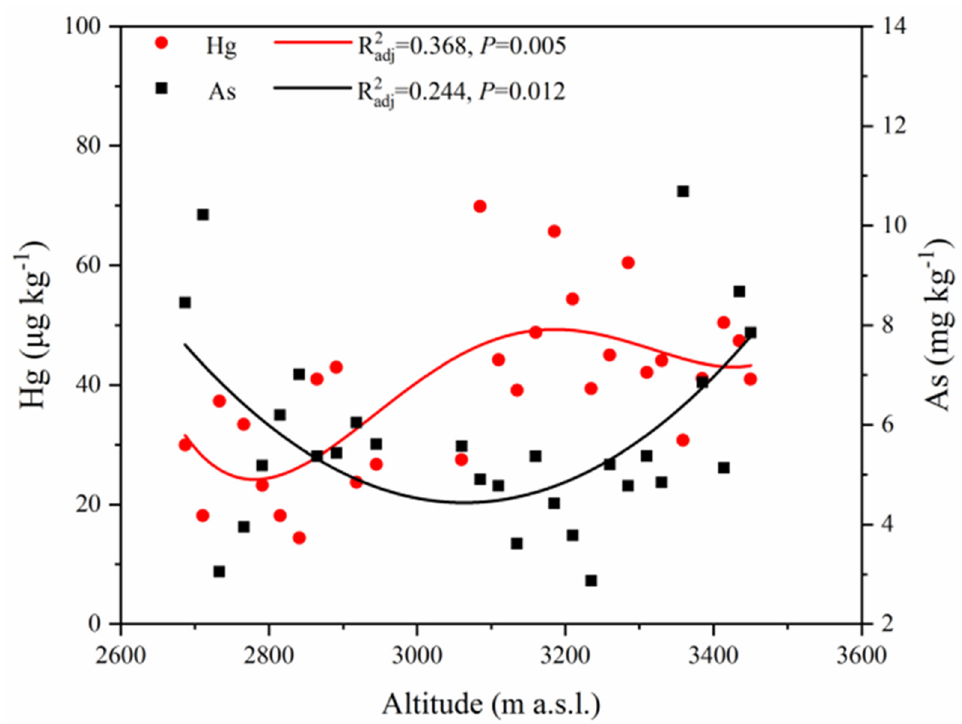
Figure 2. The altitudinal distributions of Hg and As in the topsoil.